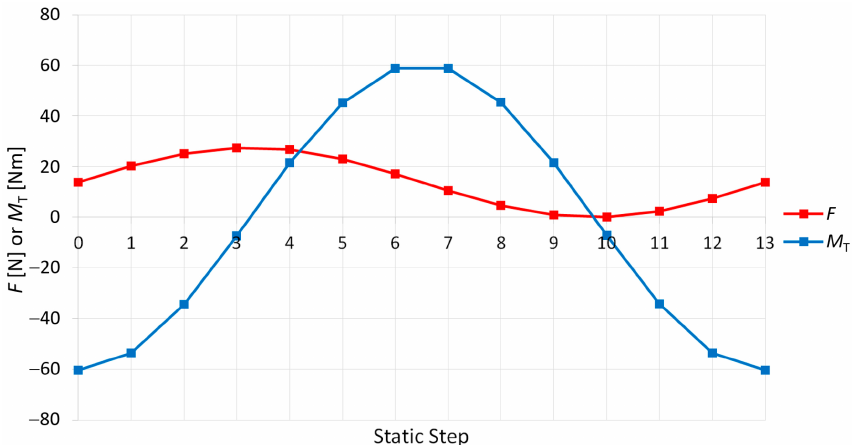
Figure 18. Load sequence of specimen 0_1_90_3 discretized in static